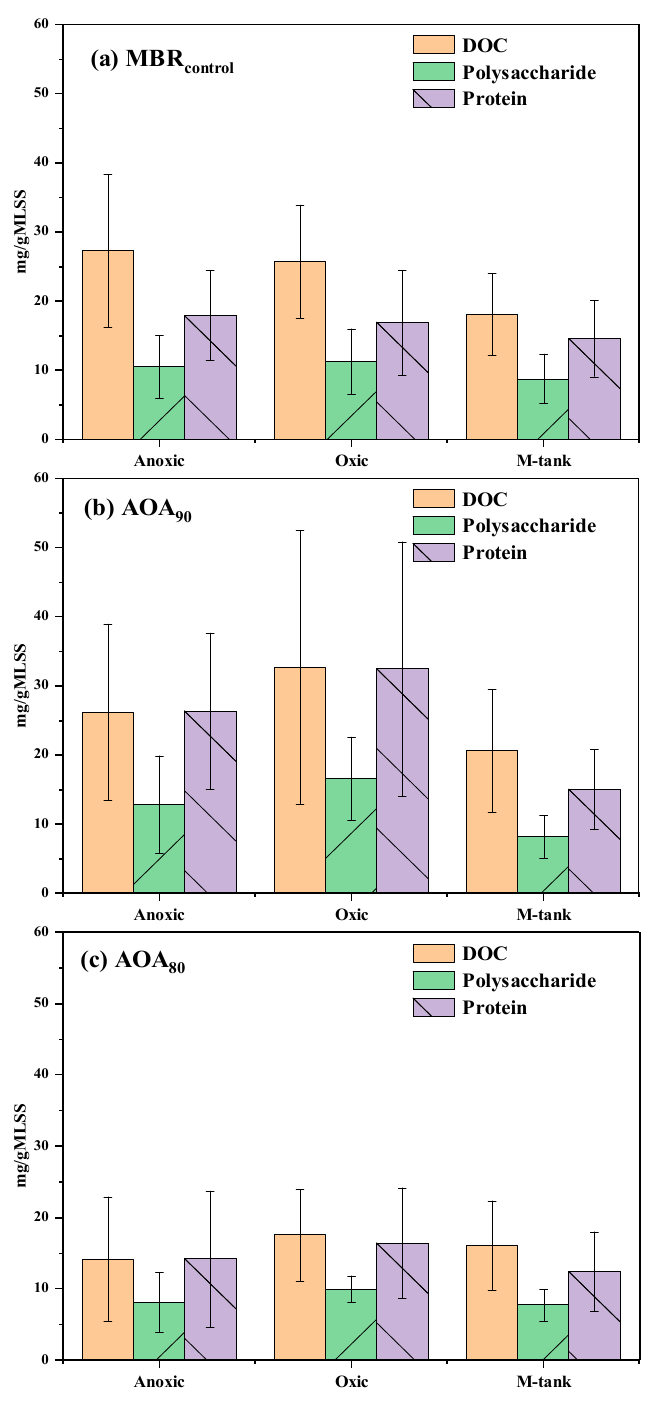
Figure 3. The average of total EPS in terms of DOC, polysaccharides, and protein in different units of bioreactors ( n = 14).